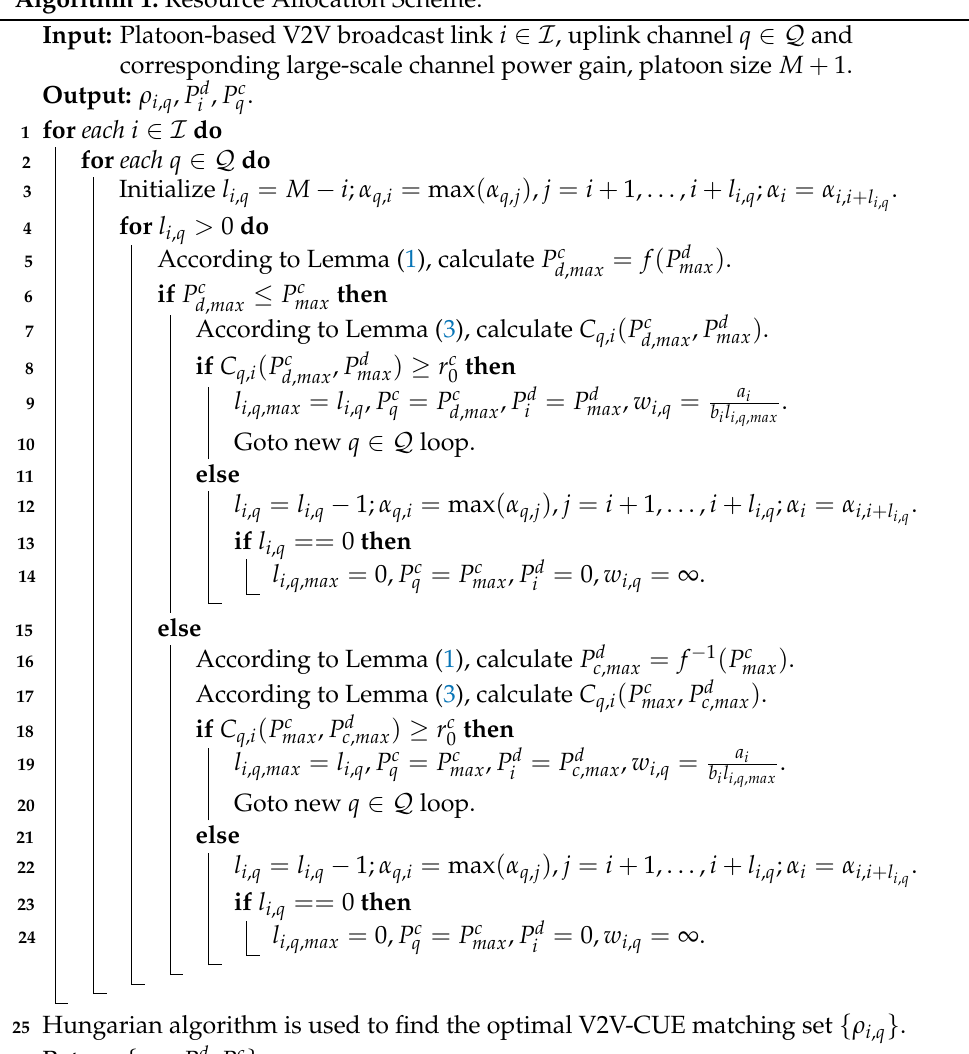
Algorithm 1: Resource Allocation